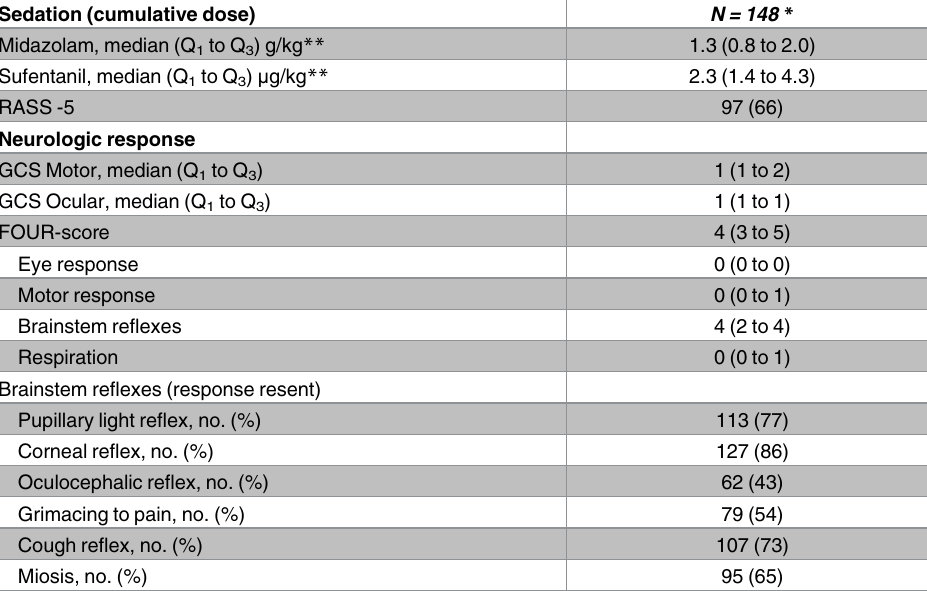
Table 2. Neurological assessmentat the time of